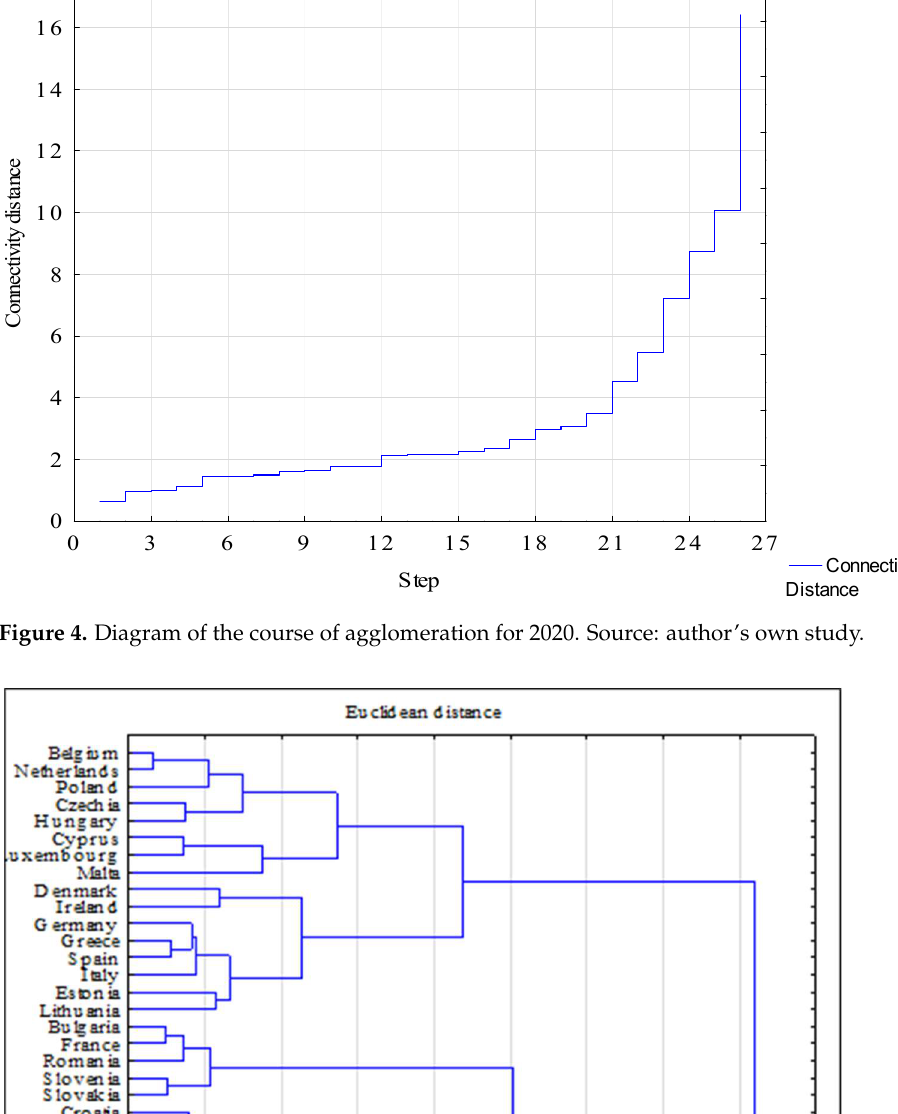
Figure 3. Clustering of EU countries with similar levels of RES development in 2012. Source: au- thor’s own study. Euclidean distance